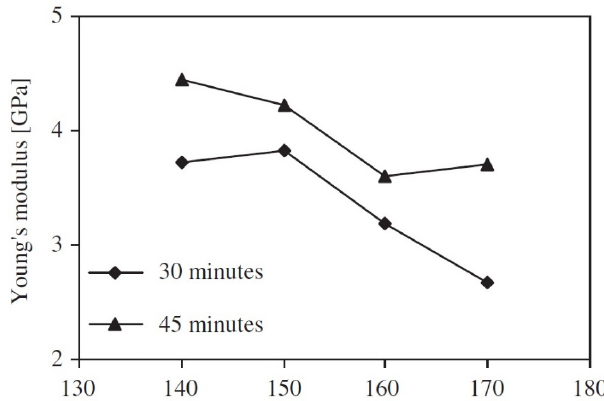
Figure 10. Young’s modulus at 23 °C for various mold temperatures and for various polymerization times. Dry as-molded properties. Reprinted from Reference [8], under open-access license.